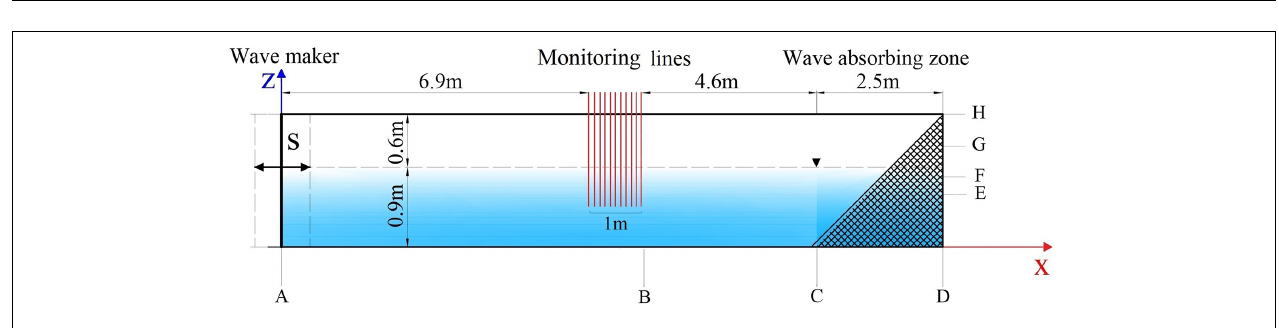
FIGURE 2 | General arrangement sketch of the 2-D wave